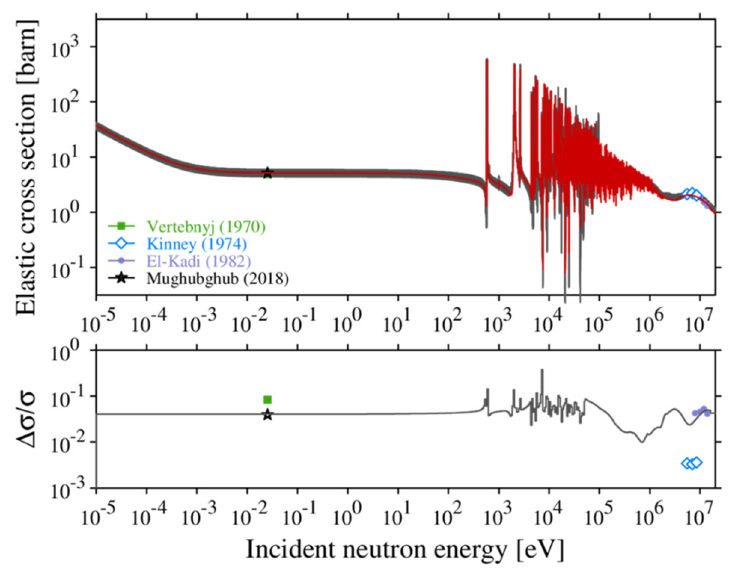
Fig. 3. 63 Cu neutron elastic cross sections estimated by T6 system (gray lines) compared with ENDF/B-VIII.0 (red line) and experimental data